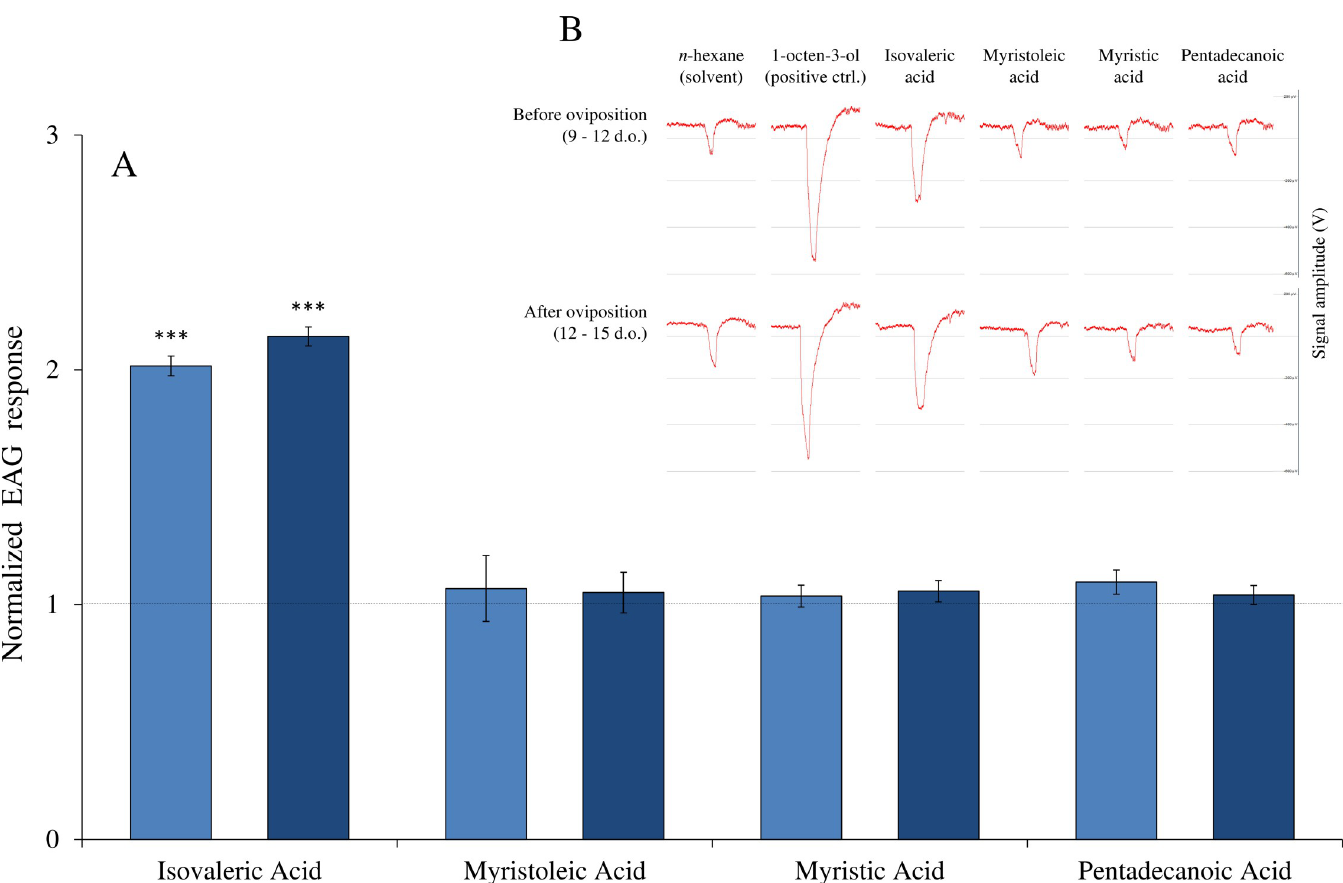
Fig 3. A : Normalized antennal responses of engorged Aedes aegypti females towards synthetic compounds at 10 − 4 g (mean ± S.E.M., n = 10 individuals per group). Normalized EAG values correspond to the response to the compound divided by the response to the solvent (i.e. hexane). Light blue bars correspond to females before oviposition (9–12 days old); dark blue bars correspond to females after oviposition (12–15 days old). Asterisks indicate significant differences in the antennal perception compared to the solvent (Tukey’s post-hoc test: ��� P < 0.001). B : Exemplar traces obtained from Autospike 1 software for the two groups of mosquitoes toward the different test